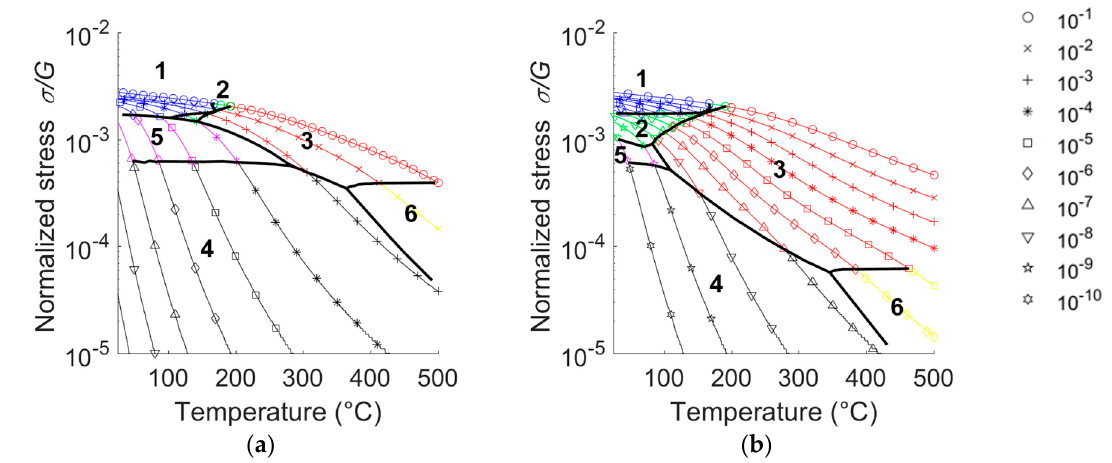
Figure 4 . Exemplary deformation maps for pure Al. Normalized stress [-] for different temperatures and strain rates for ( a ) 5 μ m and ( b ) 50 μ m. The black, bold lines indicate transitions between the deformation regimes. The numbers indicate the dominant deformation mechanisms: dislocation glide (1); LT creep (2); HT creep (3); Coble creep (4); D gb -controlled GBS (5) and D l -controlled GBS